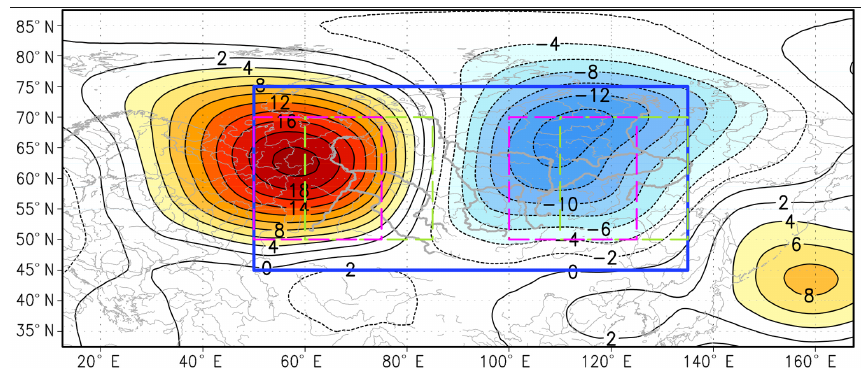
Figure 4. Spatial pattern of EOF2 (19.9% of explained variance) for the summertime Z500 over Siberia (blue line inset box: 45–75 ◦ N, 50–135 ◦ E, covering the three great Siberian rivers). Green (magenta) dashed inset boxes cover almost all areas of the Lena and Ob river basins (western and eastern centers of action of EOF2). The EOF analysis is based on JRA-55.